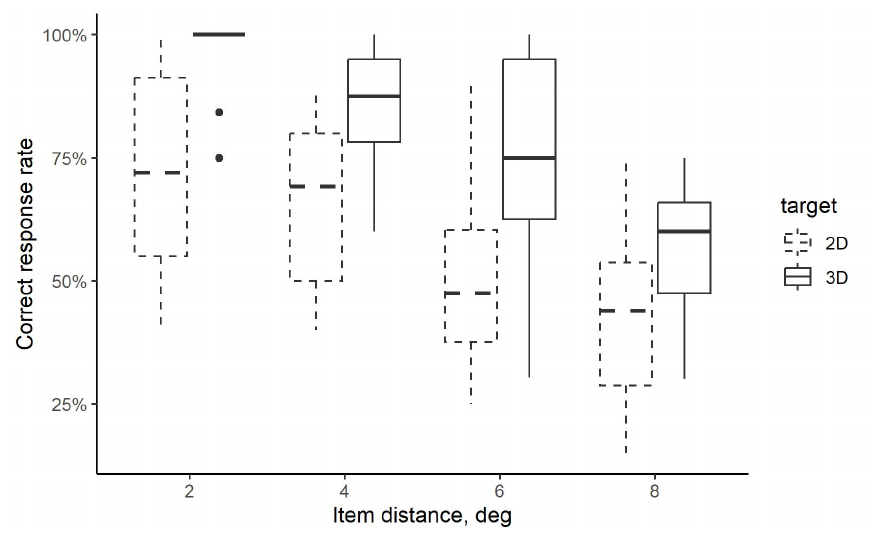
Figure 3. Mean correct response rates for all subjects when responding to 3D images (target-present trials) and 2D images (target-absent trials) with items presented at four distances from the plane center on the multi- plane display. Box plots present median and interquartile